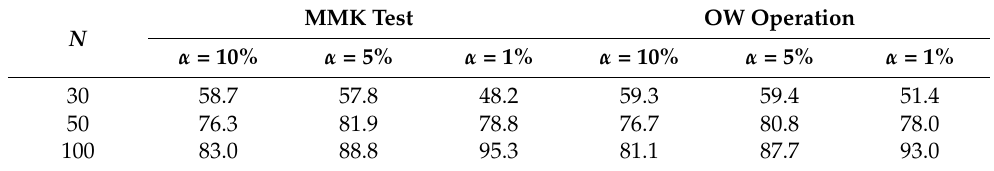
Table 2. Accuracy rates of trend tests in simulation experiment 1 at different significance levels. Unit: %. MMK N